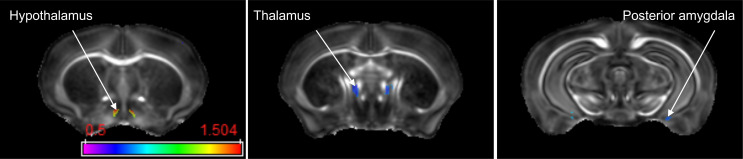
Effect of sex on local changes in fractional anisotropy (FA), FDR < 0.3, p<0.0004, minimal cluster size = 1 voxel.1 = no change; <1 (blue) reduced FA in males; >1 (green/red) increased FA in males, n = 6 per rearing condition and sex.